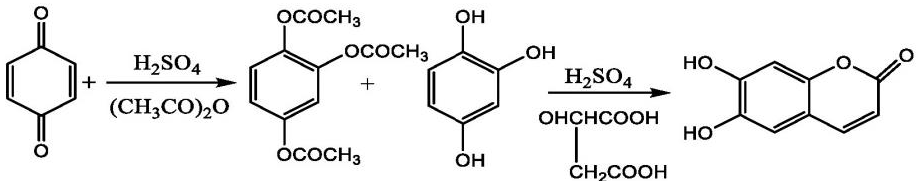
Figure 9. Synthesis of esculetin using p-benzoquinone, sulfuric acid and acetoacetate.